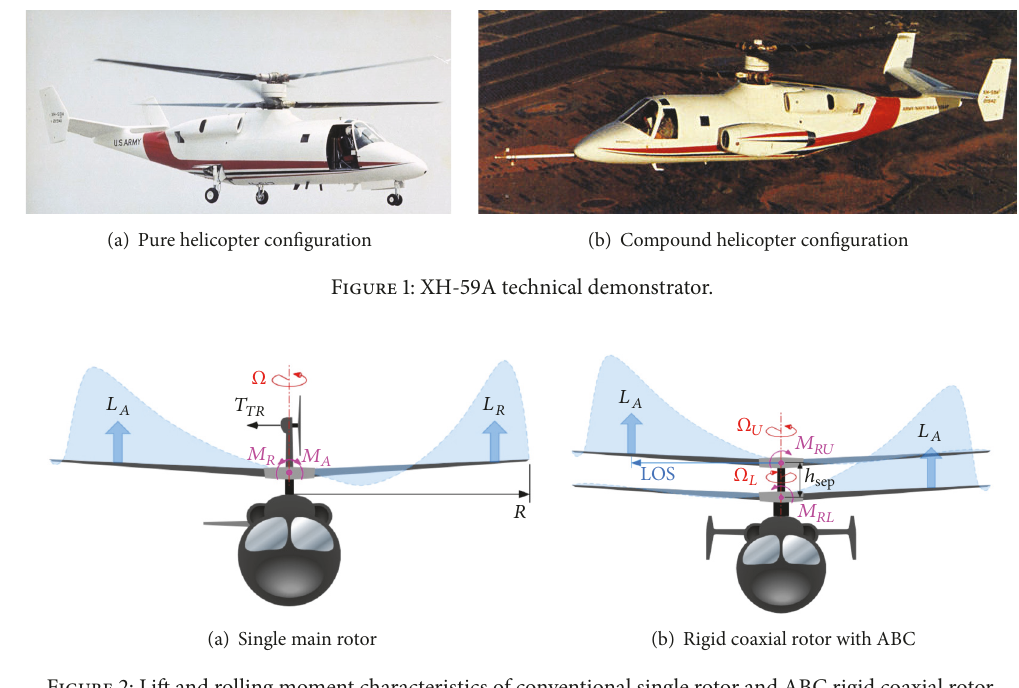
Figure 2: Lift and rolling moment characteristics of conventional single rotor and ABC rigid coaxial